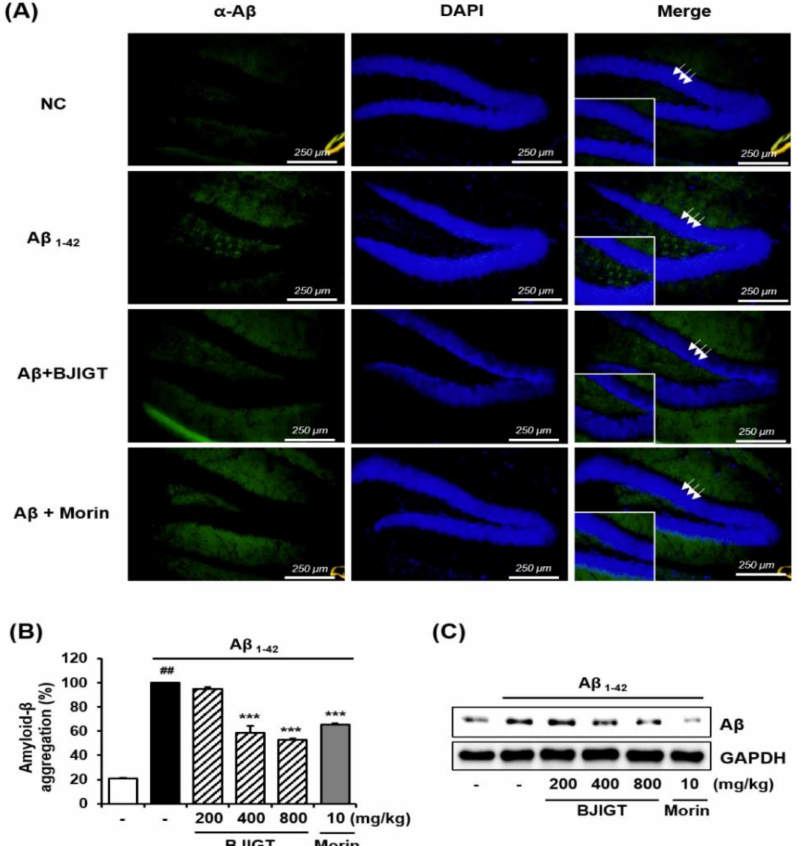
Figure 3. Effects of BJIGT on A β aggregation in an A β -induced AD mouse model. ( A )